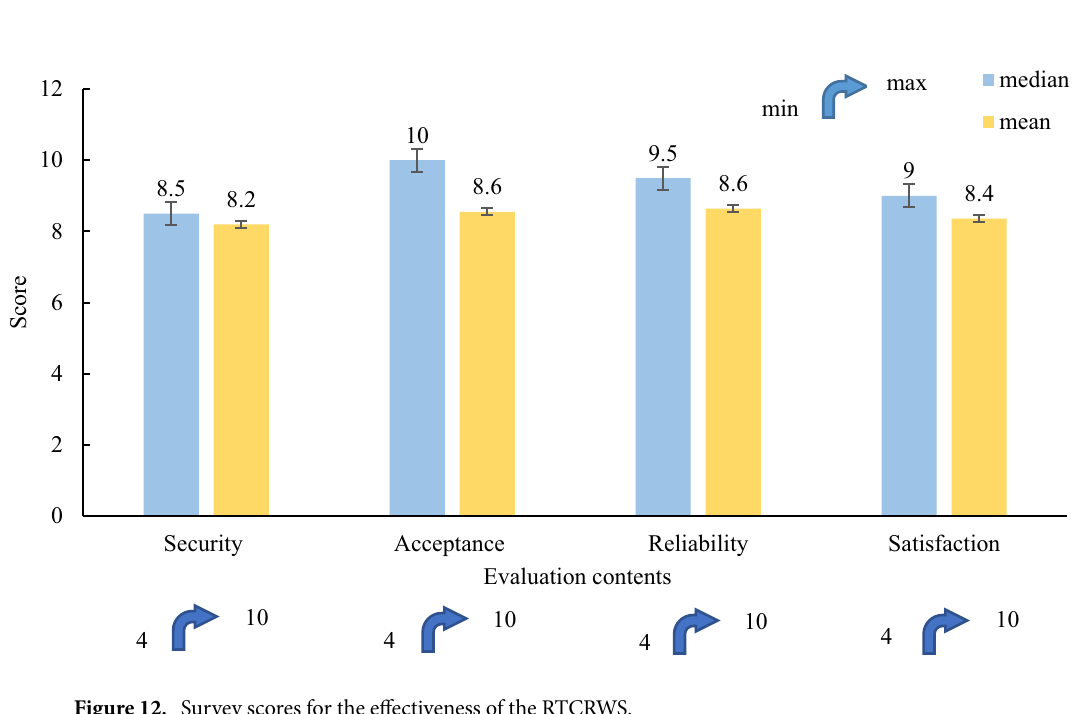
Figure 12. Survey scores for the effectiveness of the